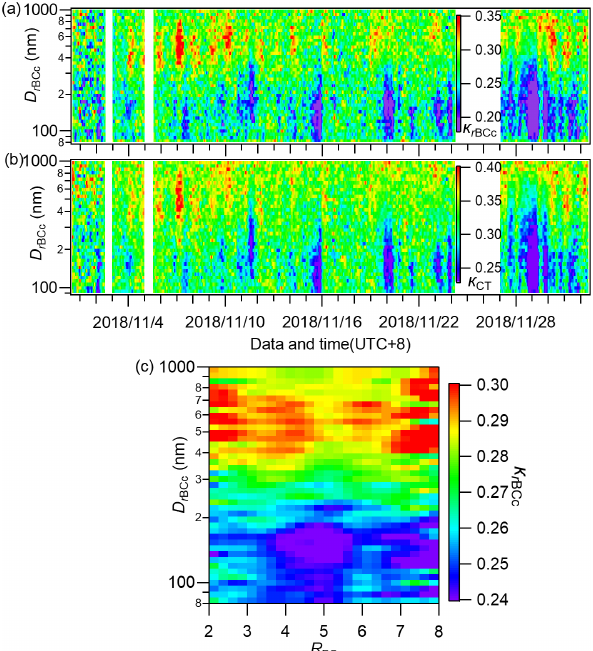
Figure 11. Image plots of the size-resolved hygroscopicity param- eters of (a) rBCc particles ( κ rBCc ) and (b) their coating materials ( κ CT ) during the whole campaign, and (c) the campaign-average size-resolved κ rBCc at different R BC